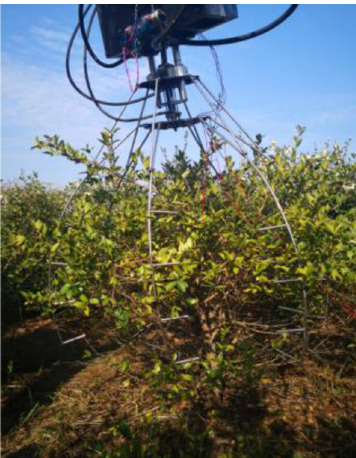
Fig. 7. Acceleration testing of slider in a camellia fruit